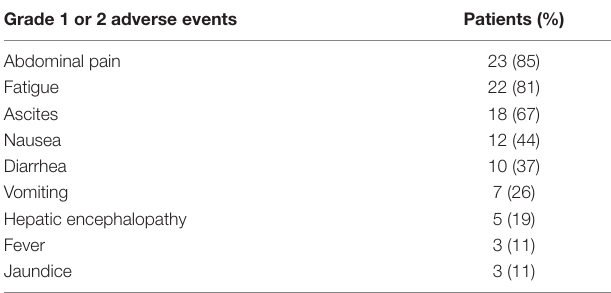
TaBle 3 | clinical toxicities following